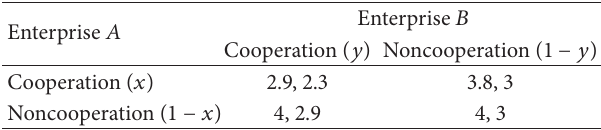
Table 3: The specific payoff matrix for enterprise 𝐴 and enterprise 𝐵 . Enterprise 𝐴